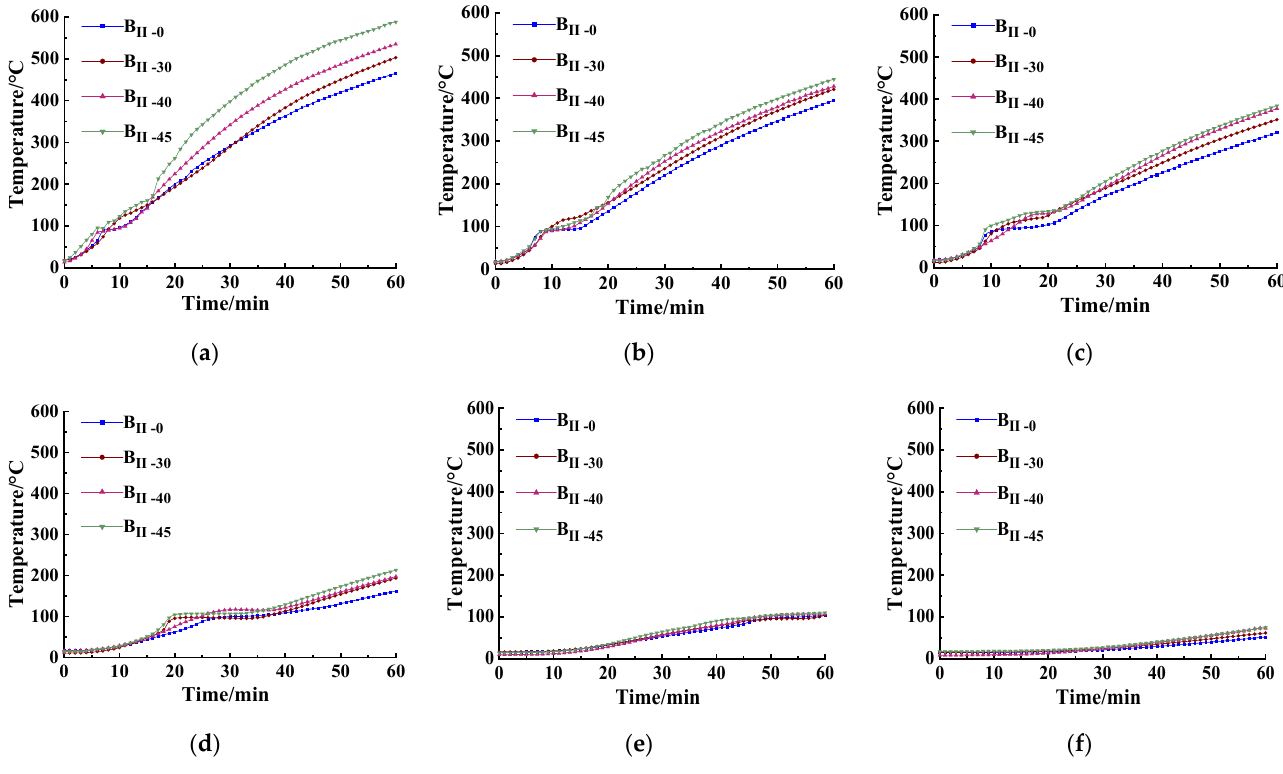
Figure 8. Temperature–time curves at different distances from the fire surface: ( a ) 10 mm; ( b ) 20 mm; ( c ) 30 mm; ( d ) 50 mm; ( e ) 80 mm; ( f ) 120 mm.